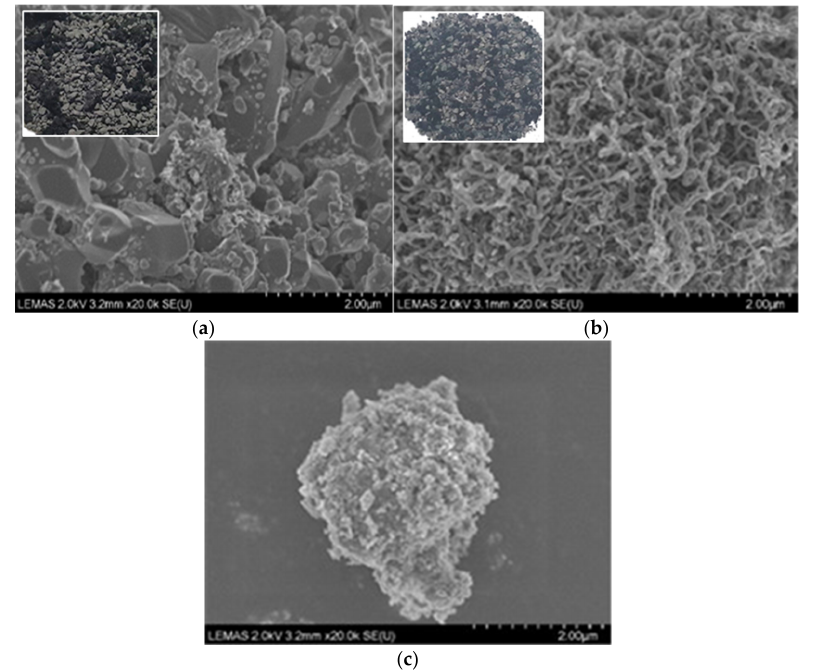
Figure 6. Naked eye (inserts) and SEM images of the used ( a ) Ni-Al, ( b ) Ni-CaAl, and ( c ) Rh-Al catalysts in packed bed. Acetic acid flow, 1 mL/h, 1 g of catalyst, S/C = 2, λ = 0.353 (Air flow = 22 mL/min), 570 °C and 1 bar. 570 ◦ C and 1